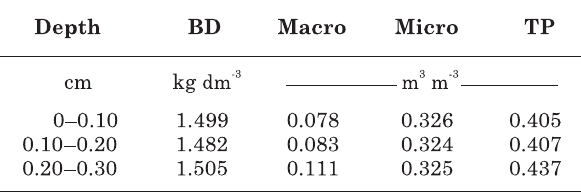
Table 2. Soil bulk density (BD), macroporosity (Macro), microporosity (Micro) and total porosity (TP) of the layers 0–0.10 m; 0.10–0.20 m; experimental area (average of 30